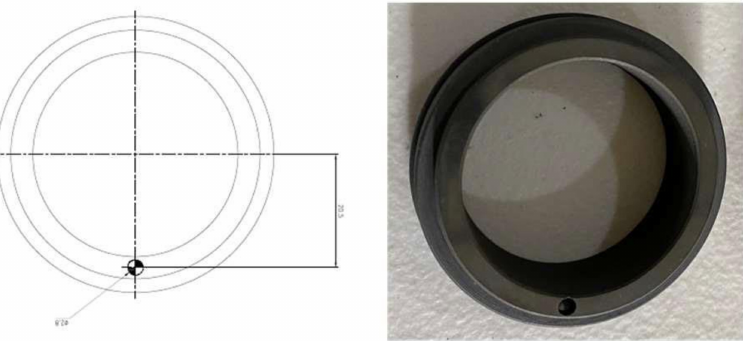
Figure 5. MS hole fault.